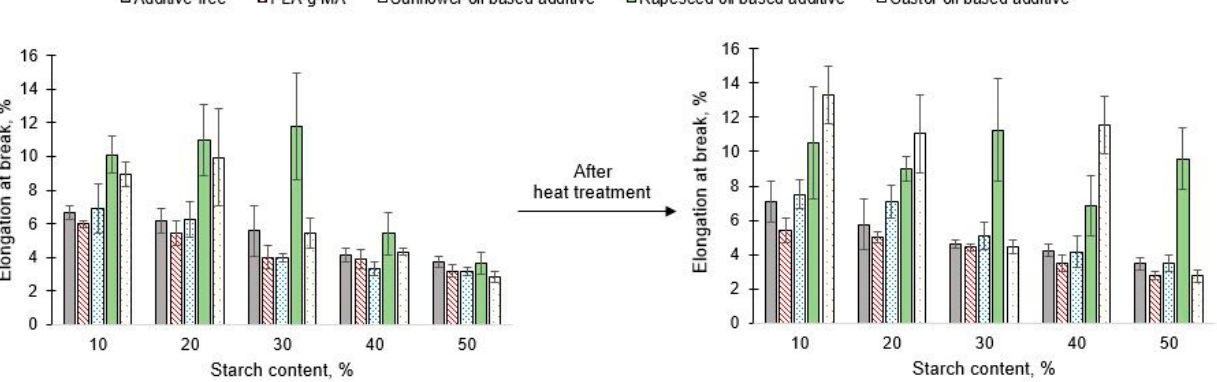
Figure 10. Elongation at break of unconditioned and conditioned PLA/starch blends.